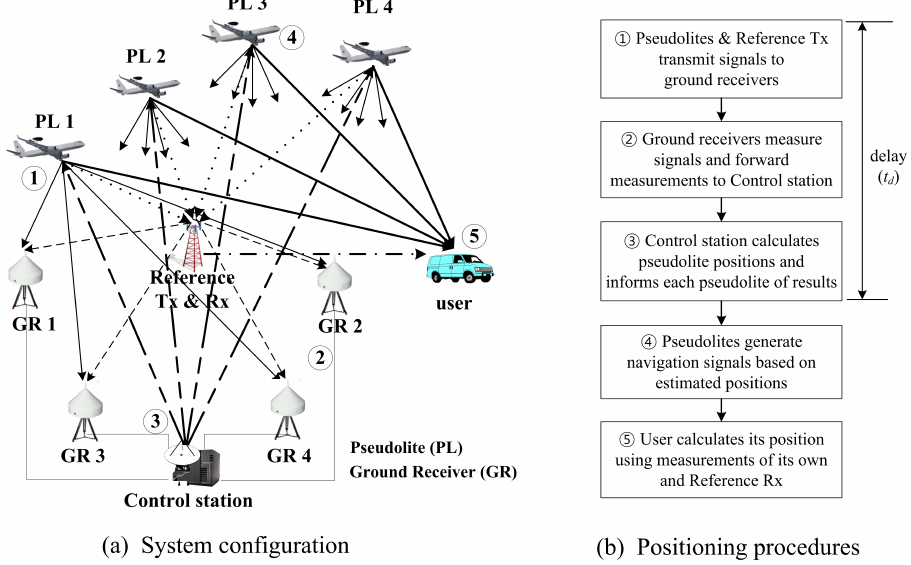
Figure 1. Airborne-based pseudolite positioning system based on the Inverted Global Positioning System (IGPS)